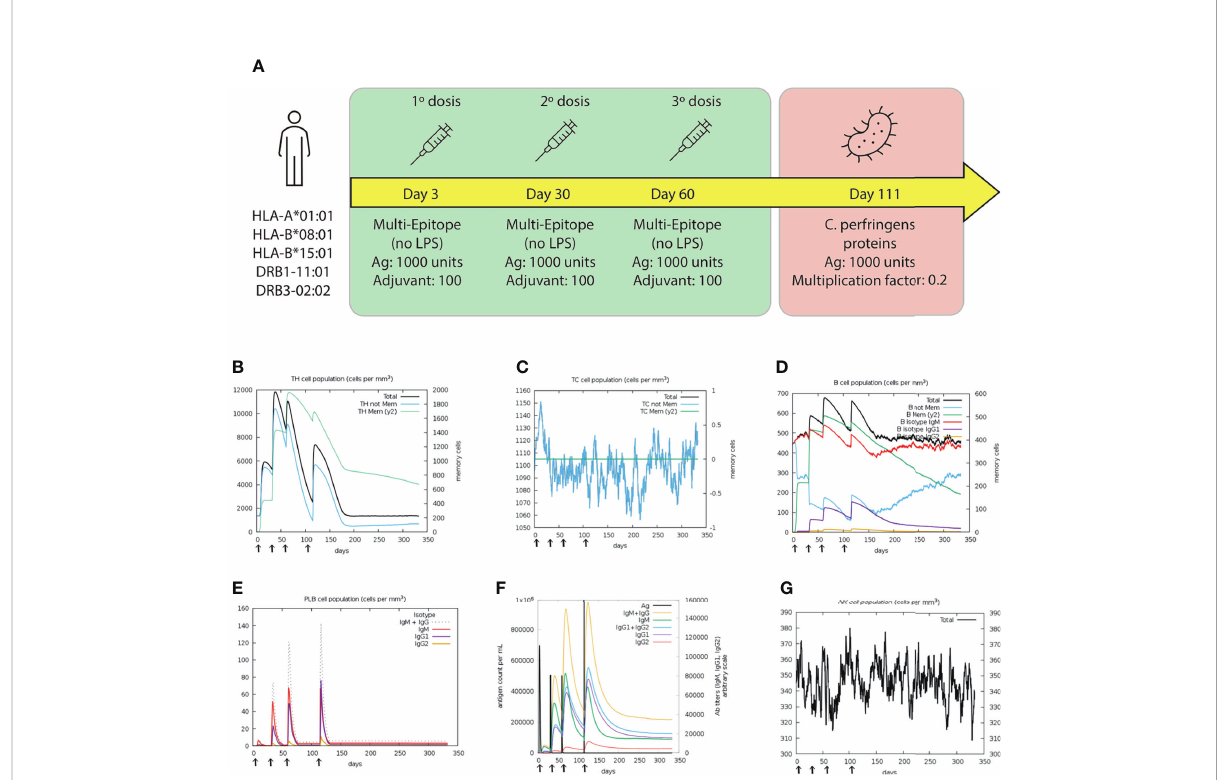
FIGURE 10 Results of the C-IMMSIM simulation for 350 days. (A) Schematic illustration of the vaccination trial, with three doses of the multi-epitope vaccine (green box) at days 3, 30, 60; and the challenge (red box) at day 111. Dynamics of (B) HTL and (C) CTL populations. Memory and not memory cells are represented with light-blue and green lines, respectively. (D) B cell populations, grouped by immunoglobulin isotype production. (E) Population of Plasma B lymphocytes producing IgM, IgG1 and IgG2. (F) Antigen concentration and relative antibodies responses. (G) Total population of NK cells. The fi rst, second and third doses were